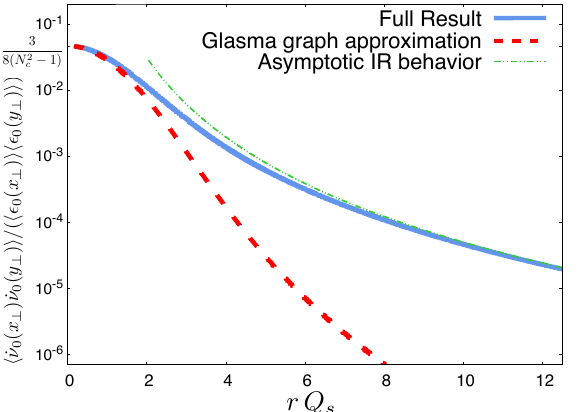
Figure 1. Two-point correlator of the divergence of the Chern-Simons current normalized to the product of energy density averages in the exact analytical approach (blue full curve) and the Glasma Graph approximation (red dashed curve). As a visual aid we also indicate the asymptotic behavior in the infrared limit, which is 32 = [( N 2 1) 2 r 4 Q 4 ] (green dot-dashed c (cid:0) s